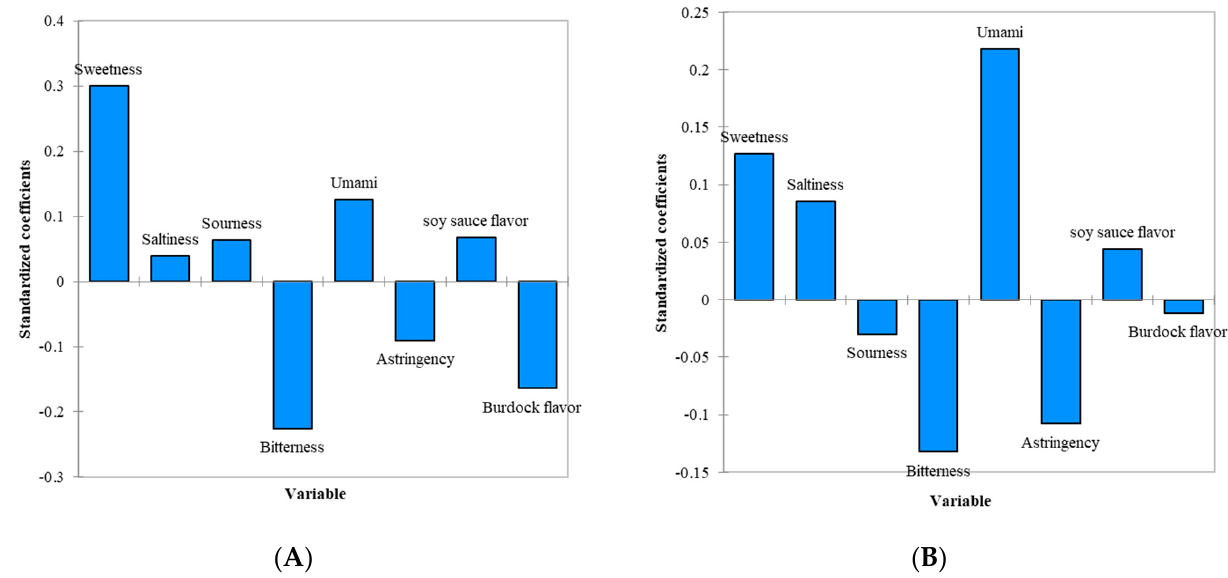
Figure 3. ( A ) Standardized coefficients from the PLS regression for simmered burdock root with 15.0% sugar in the absence of MSG. ( B ) Standardized coefficients from the PLS regression for simmered burdock root with 7.5% sugar in the presence of 0.16% MSG.